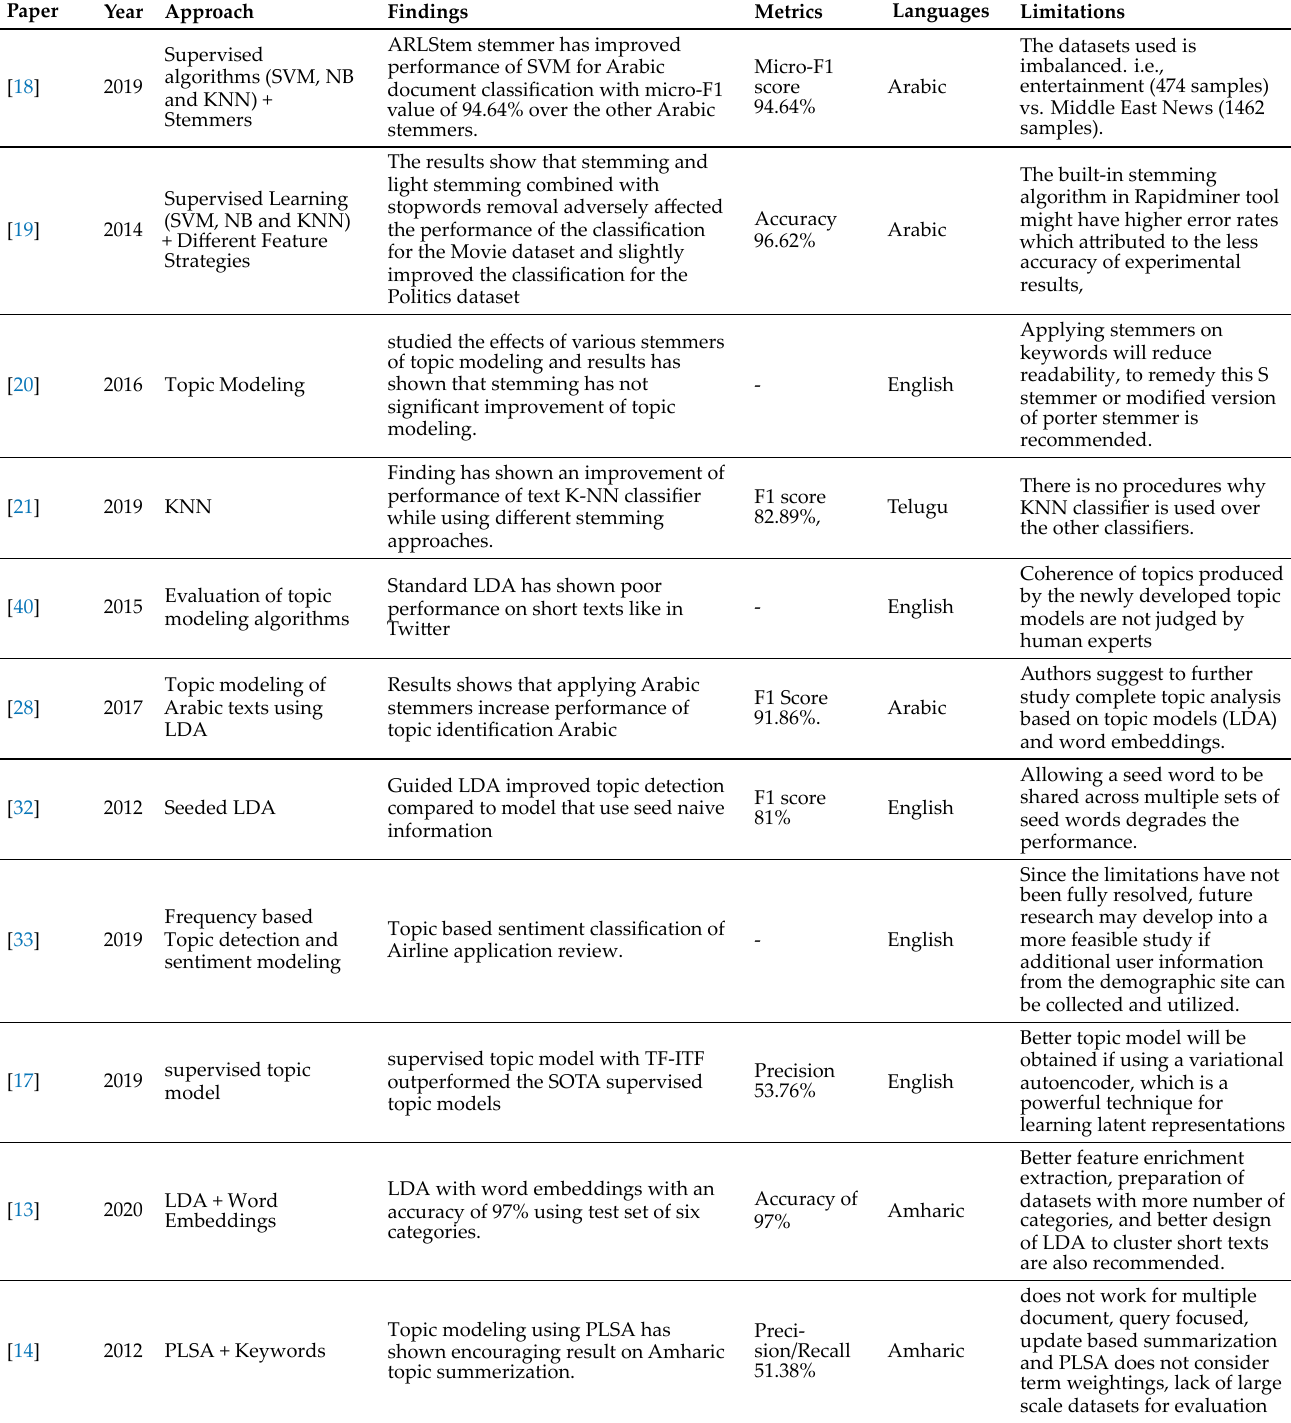
Table 1. Summary of Key Related Work of Supervised Topic